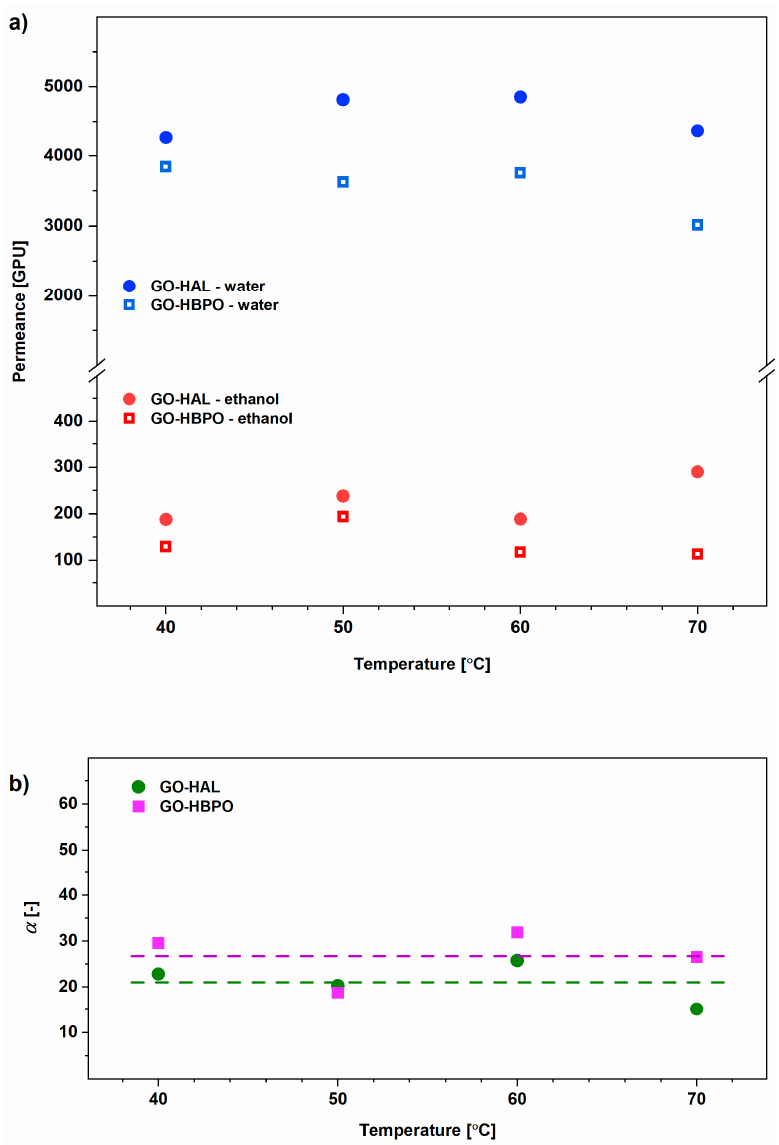
Figure 2. ( a ) Permeance of pure water (blue symbols) and absolute ethanol (red symbols) through GO-HAL (humic acid-like crosslinker) and GO-HBPO (hyperbranched polyol) membranes, and ( b ) ideal water/ethanol selectivity of the two membranes as a function of the feed temperature (°C); dotted lines indicate the average of the selectivities for the two membranes. The permeance values have been expressed in Gas Permeation Units (GPUs), where 1 GPU = 3.35 × 10 − 10 mol·(m 2 ·s·Pa) − 1 [47].